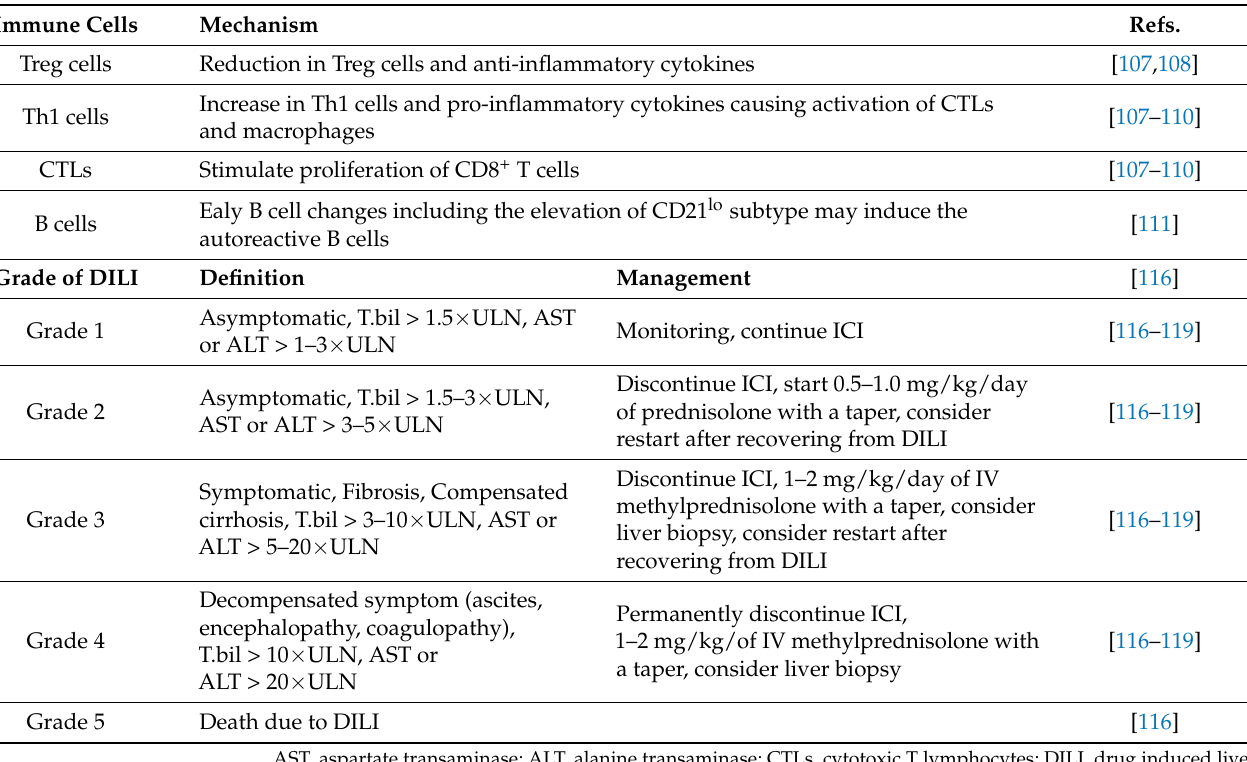
Table 2. Mechanism and treatment of drug-induced liver injury caused by immune checkpoint inhibitor use.